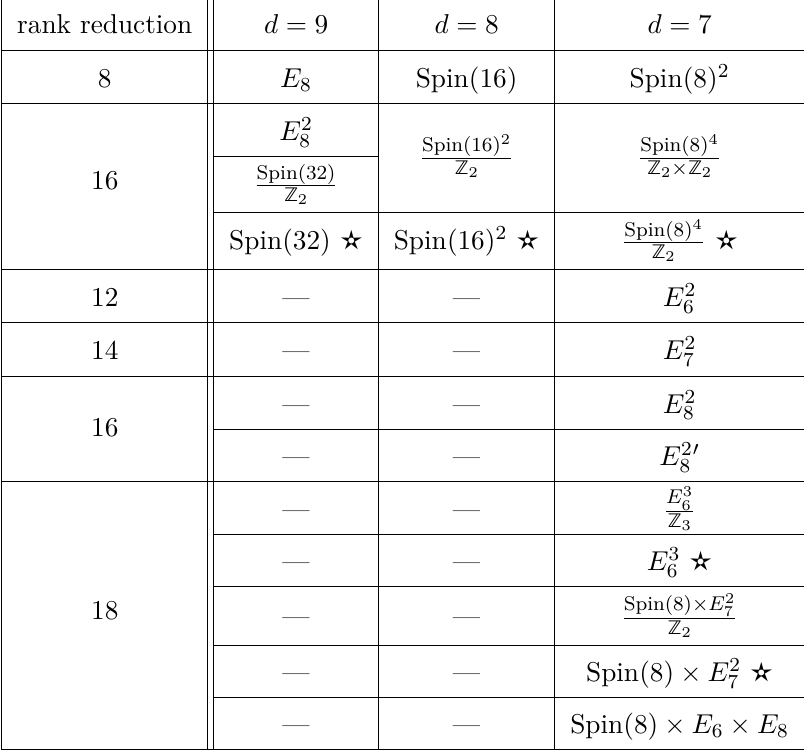
cases differ at the 8